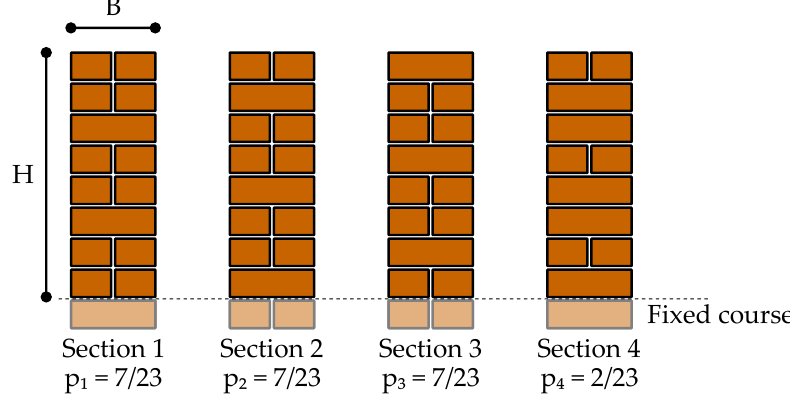
Figure 3. Four different cross-sections in the wall length illustrated for the walls with a slenderness H/B = 2.7. Recall that H refers to the wall height free to move throughout the shaking, disregarding the first fixed masonry